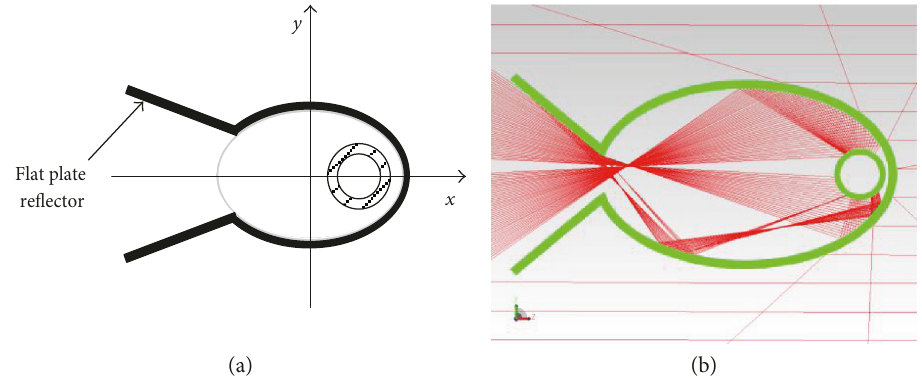
Figure 7: (a) Newly proposed elliptical cavity geometry and (b) light distribution in the